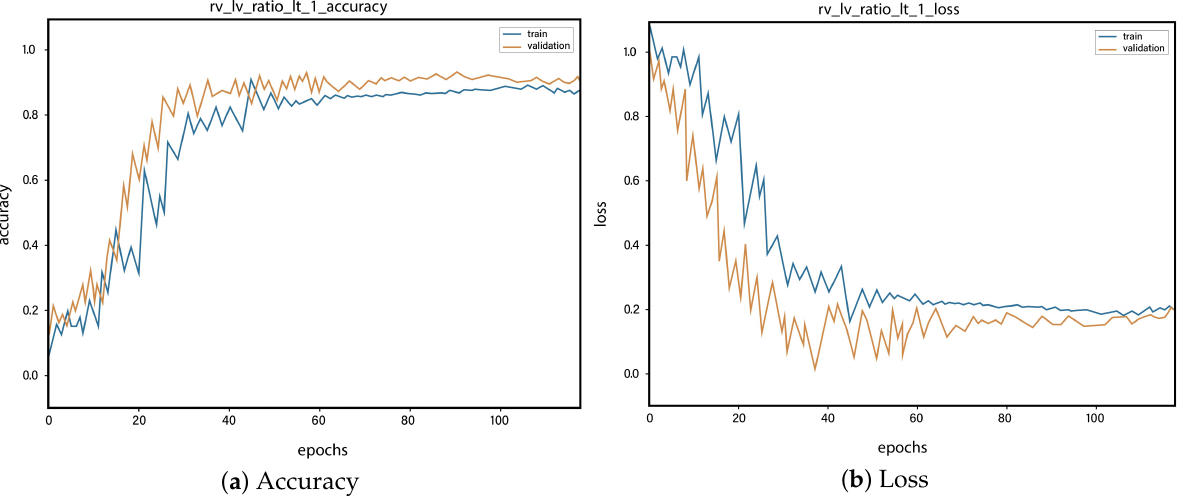
Figure 7. Training vs. validation accuracy and loss for the class: Right-ventricle/left-ventricle ratio less than 1